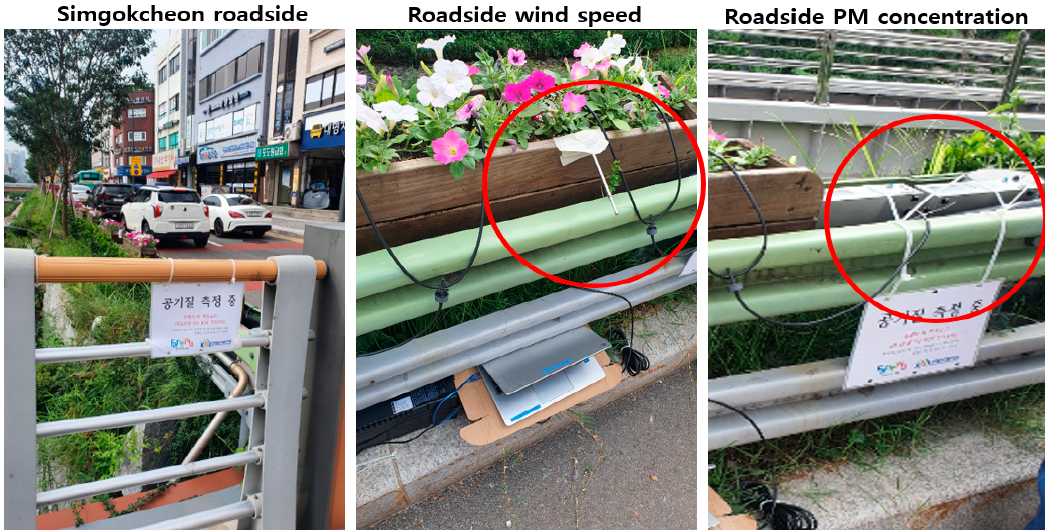
Figure 4. Setup for measuring wind speed and fine PM concentration in the ACF filter in the study area.